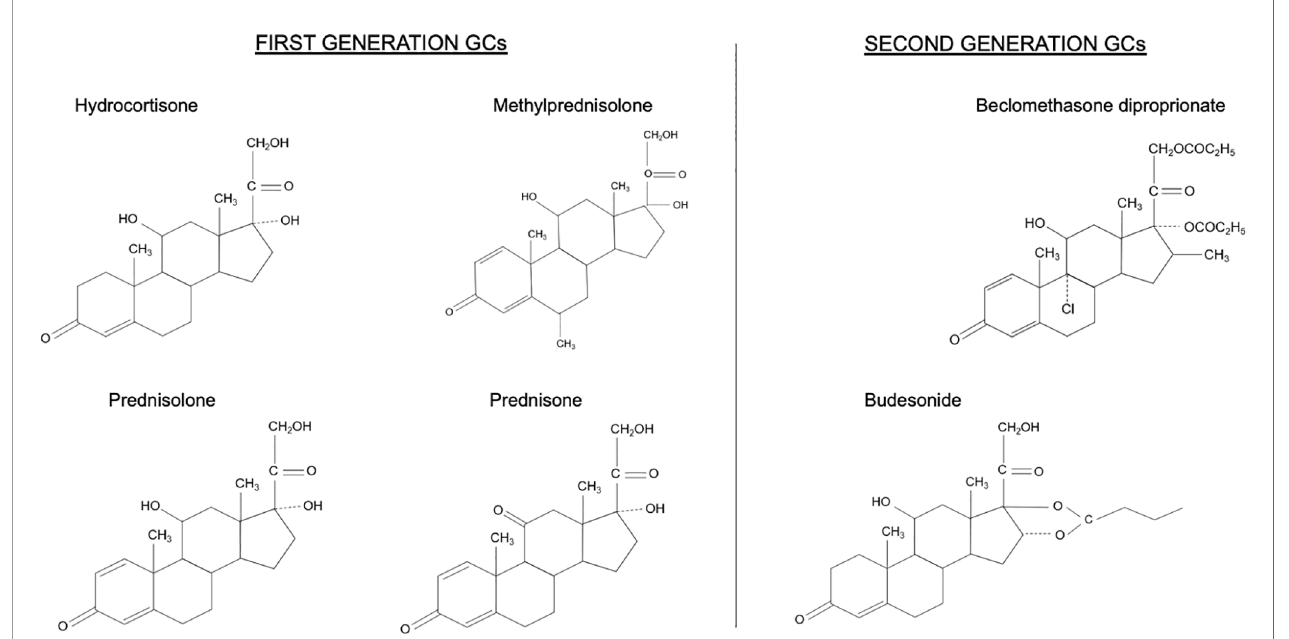
FIGURE 2 | Chemical structures of fi rst and second generation glucocorticoids